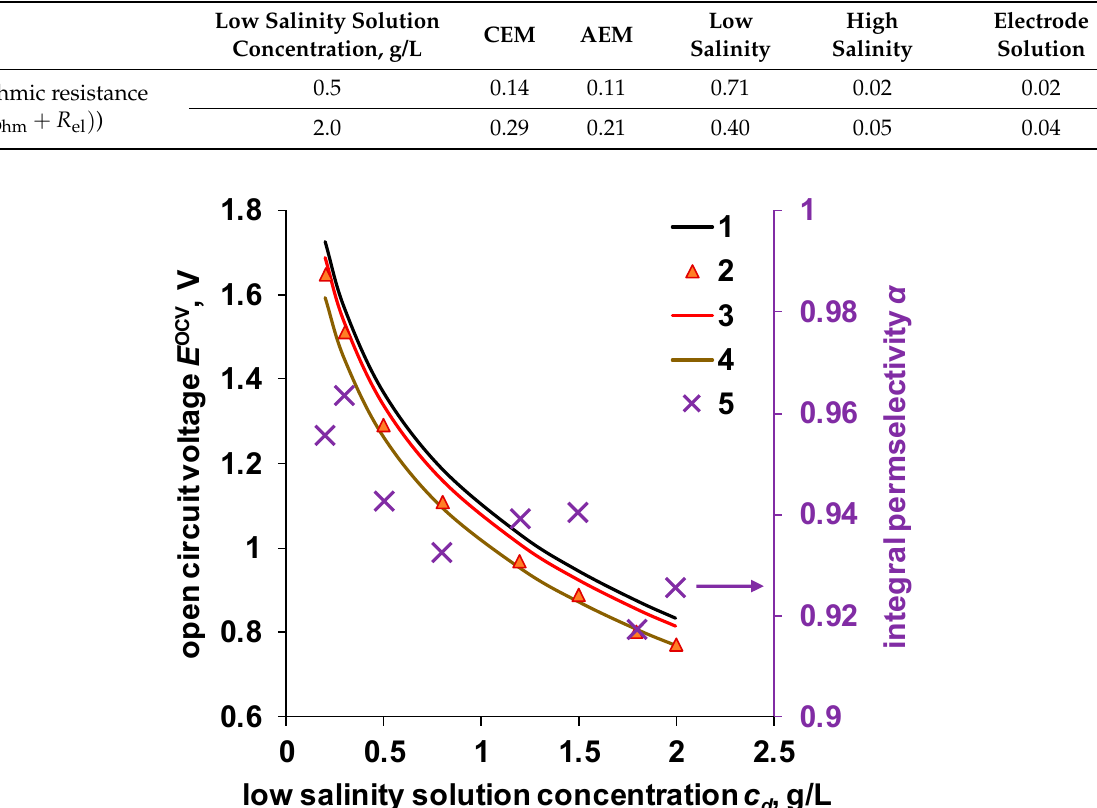
Table 6. Contribution of various components to the ohmic resistance of the reverse electrodialyzer membrane stack.